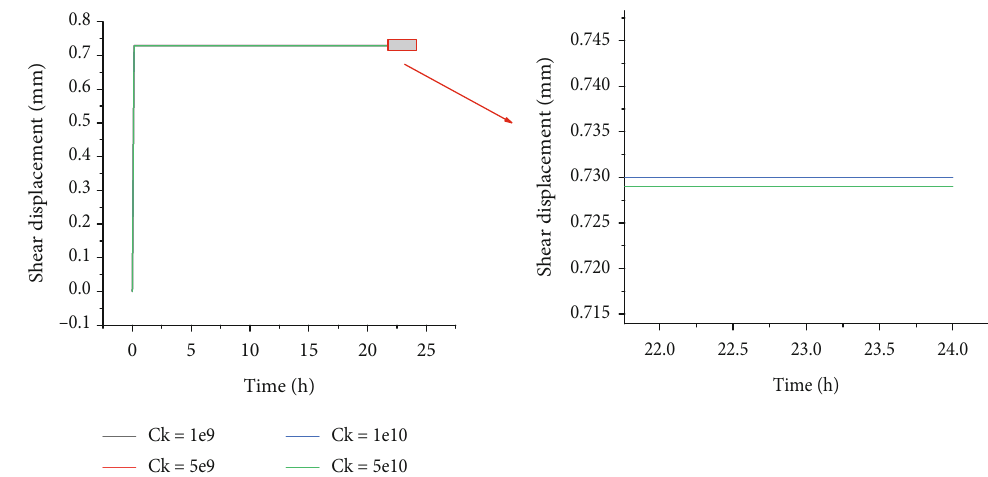
Figure 11: Shear displacement-time curves with bolts under di ff erent C